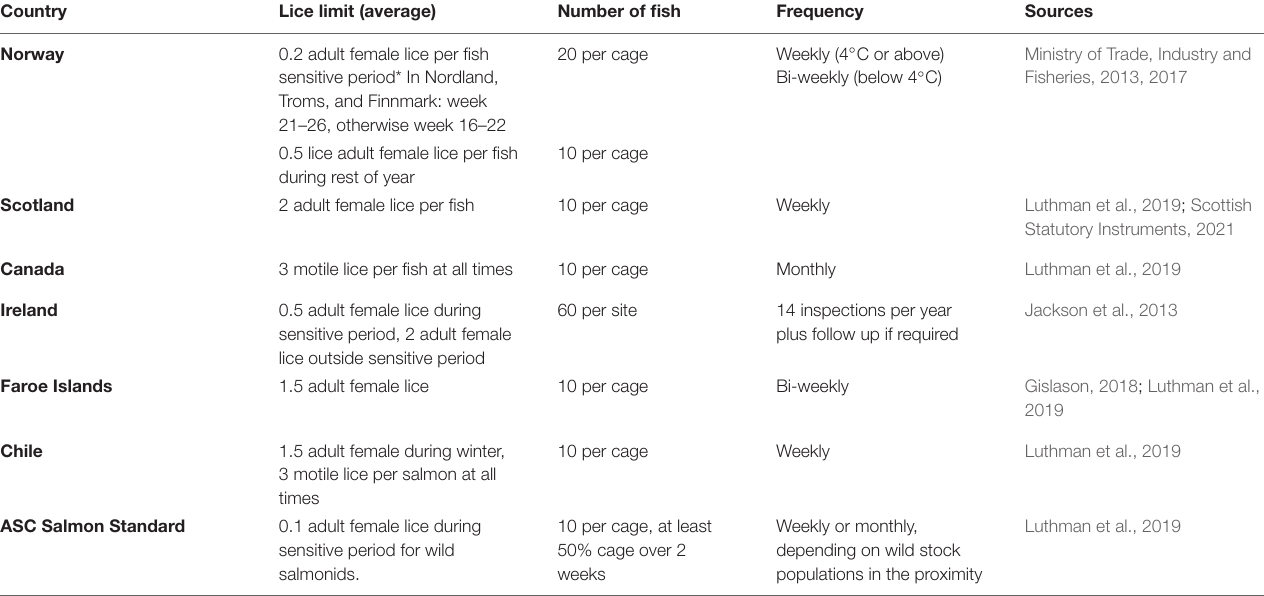
TABLE 1 | Lice abundance threshold in fish farms in various locations.